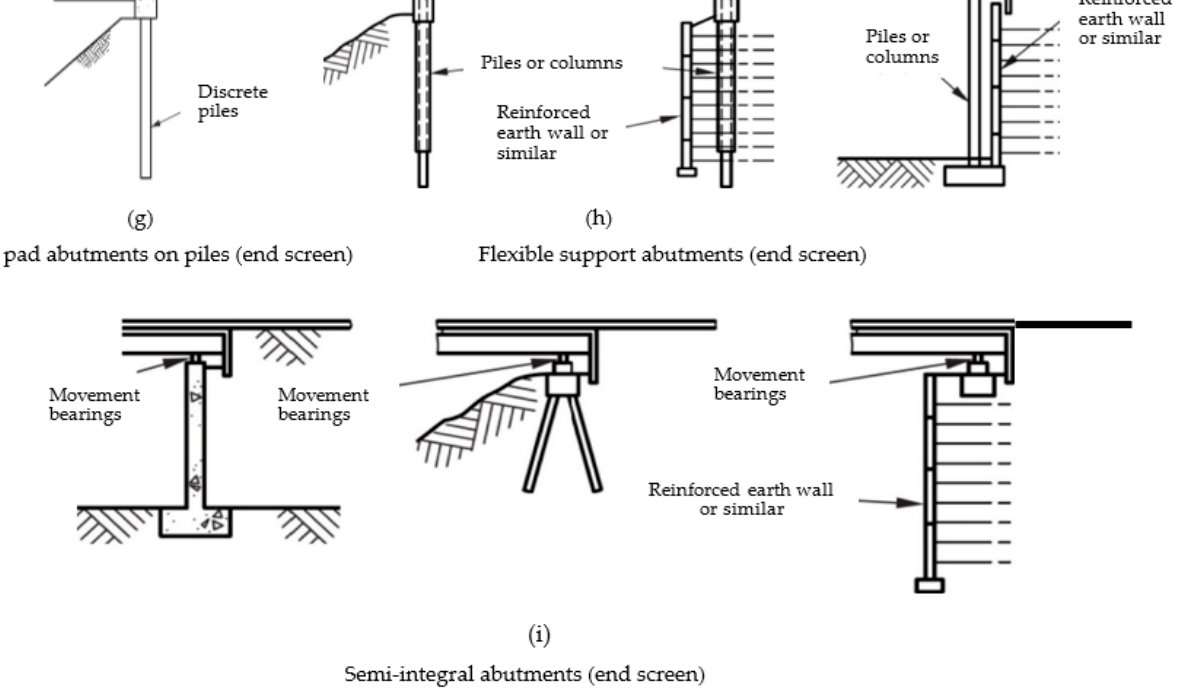
Figure 1. Types of integral and semi-integral abutments [25]. Reprinted from PD 6694-1:2011+A1:2020. Recommendations for the Design of Structures Subject to Traffic Loading to BS EN 1997-1:2004+A1:2013 ; BSI (British Standard International): London, UK, 2020 (Copyright permission BSI 2020).